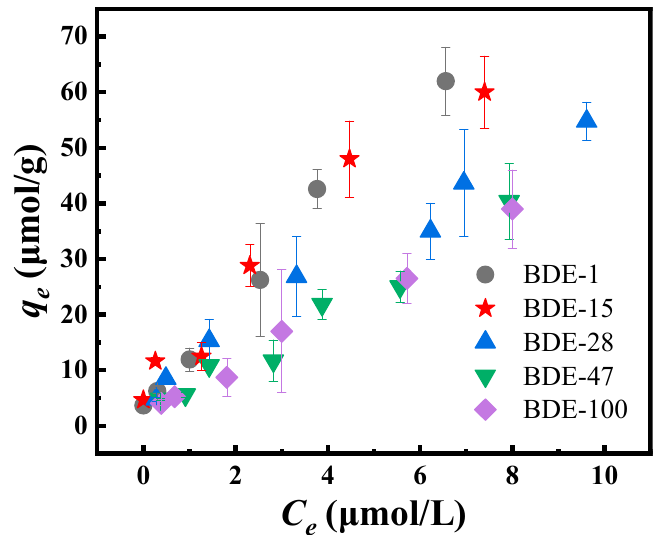
Figure 5. Adsorption of different concentrations of PBDEs by GAC (Adsorption conditions: T = 298 K; C TX-100 = 1 g/L; pH = 6; Dosage = 0.1 g/L).